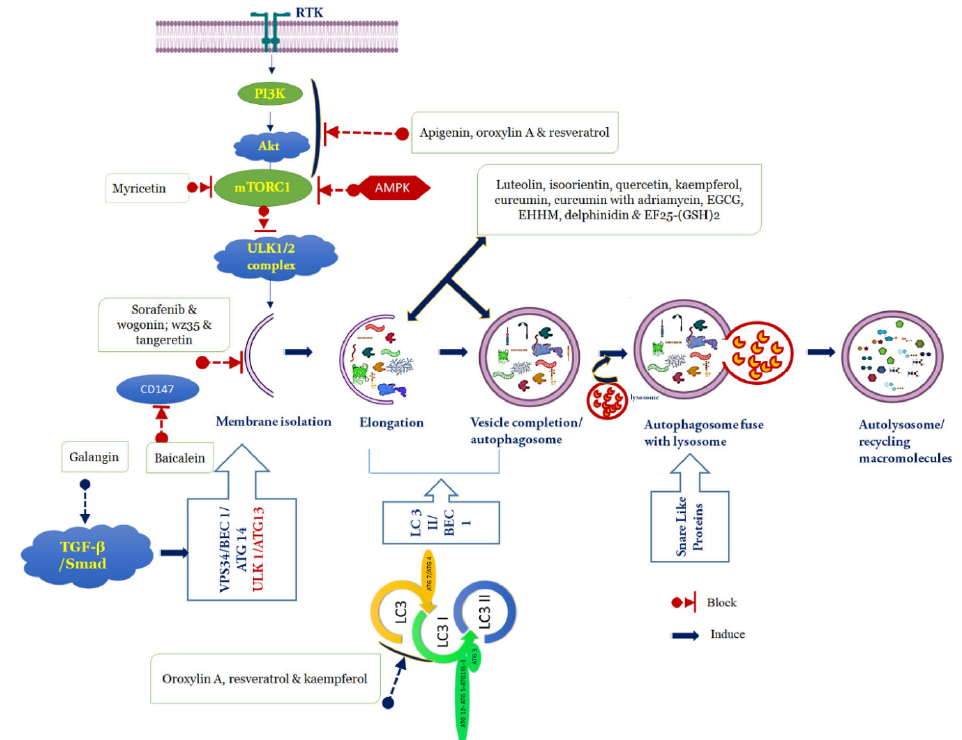
Figure 3. Schematic overview of the autophagy-induced anti-HCC polyphenols signaling pathways. Autophagy-associated signaling mechanism mediated by flavonoids against liver cancer. Apigenin, oroxylin A, and resveratrol could inhibit PI3K/Akt/mTOR signaling pathway. Luteolin, isoorientin, quercetin, kaempferols, curcumin, curcumin with adriamycin, EGCG, EHHM, delphinidin, EF25-(GSH)2 involved in the conversion of LC3 II could induce autophagy. Myricetin could inhibit the phosphorylation of mTOR signaling pathway. Oroxylin A, resveratrol and kaempferols might increase the autophagy-related proteins to increase the lipidation of LC3 II. Wogonin along with sorafenib, WZ35, and tangeretin could inhibit the autophagy pathway. Galangin might induce autophagy by TGF- β receptor/Smad signaling pathway. Baicalein may associate with negative regulation of CD147 and mediate protective autophagy through ER stress. Collectively, various polyphenols may treat HCC through the manipulation of autophagy.